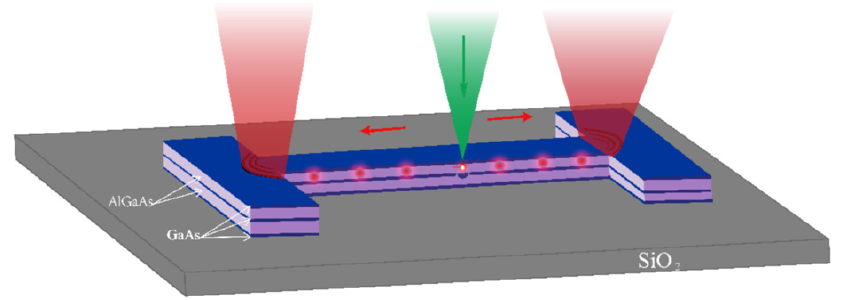
Figure 9. Design of the on-chip waveguide-coupled single-photon source [48].